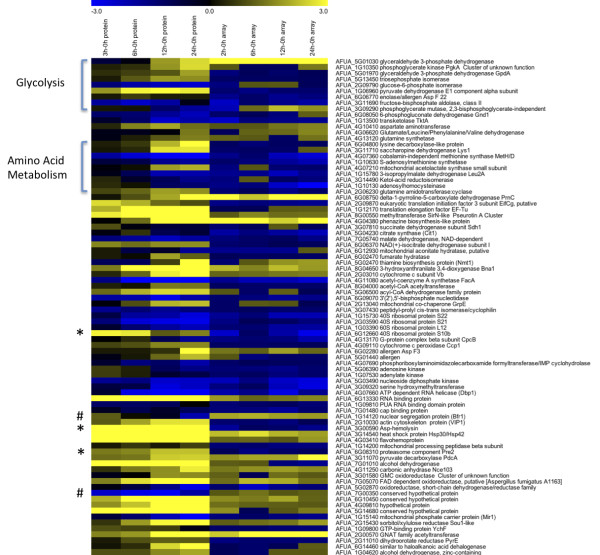
Heat map comparison of abundance levels for both transcriptomic and proteomic data. Differences and similarities between protein and mRNA levels are shown, blue indicates decreased levels, and yellow indicates increased levels. Data are sorted in the same order as additional file 4 in order of function. Highlighted with brackets are transcripts and proteins associated with glycolysis and amino acid metabolism, which showed different values for transcript and protein abundance. Additional differences are highlighted with # (transcript higher than protein) or * (protein higher that transcript).